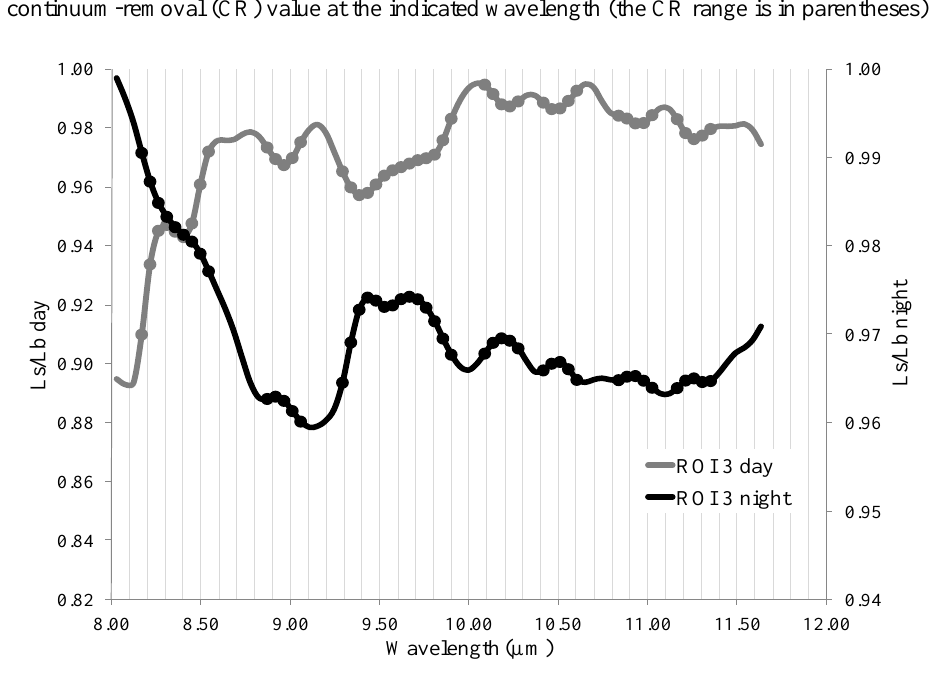
Figure 6. Day (primary y-axis) and night (secondary y-axis) Ls/Lb spectra of ROI